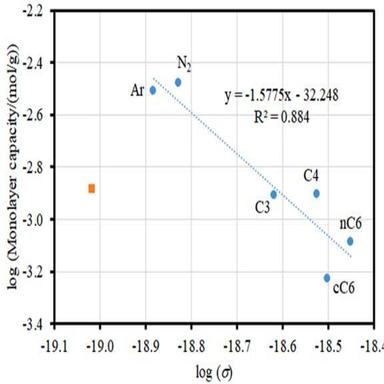
. plot of the logarithm of the monolayer capacities for water (■) and the other (labelled) adsorbates (•) on G1 against the logarithm of the molecular cross-sectional area (σ). The dashed line shows a straight-line fit (with equation and coefficient of determination shown) to the data for the adsorbates other than water.